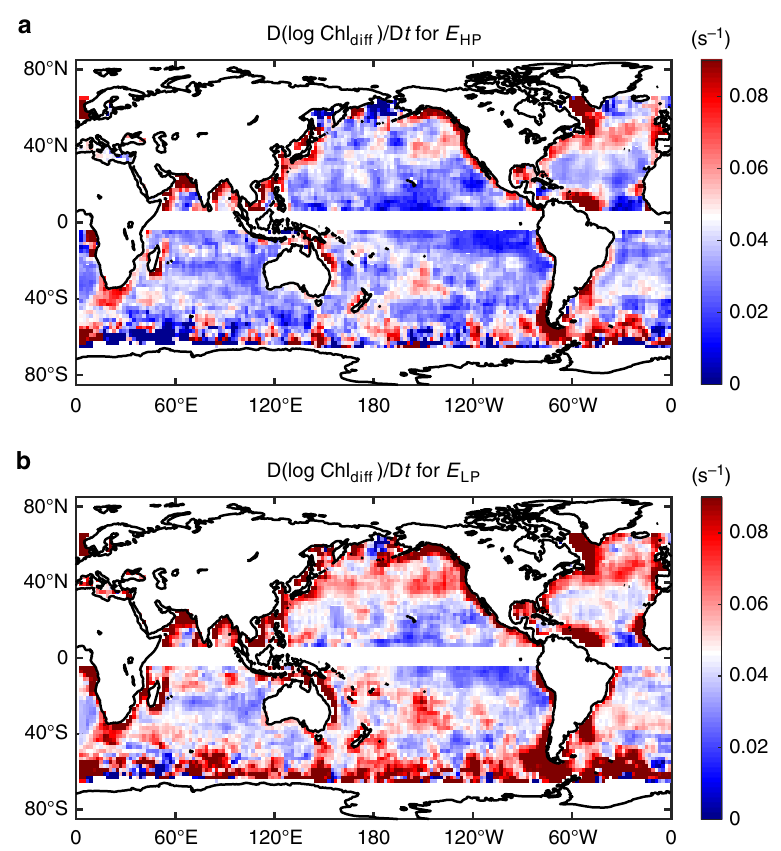
Fig. 7 Maps of chlorophyll-increasing rate differences between energy levels. Difference of the chlorophyll-increasing rate D(log Chl diff )/D t computed according to a the 7-day high-pass ageostrophic kinetic energy E HP and b the 7-day low-pass ageostrophic kinetic energy E LP . These properties are computed on a 2° × 2° global grid with a 3° × 3° moving average window. The difference of the chlorophyll-increasing rate of E HP is computed as D(log Chl diff )/D t = D(log Chl strong )/D t − D(log Chl weak )/D t , where D(log Chl strong )/D t and D(log Chl weak )/D t are the averaged chlorophyll-increasing rates for E HP > 3* E HP0 and E HP < 1/3* E HP0 in the average window, respectively, and E HP0 is the averaged E HP within the window. The difference of the chlorophyll- increasing rate of E LP is computed in the same way. Source data are provided as a Source Data fi